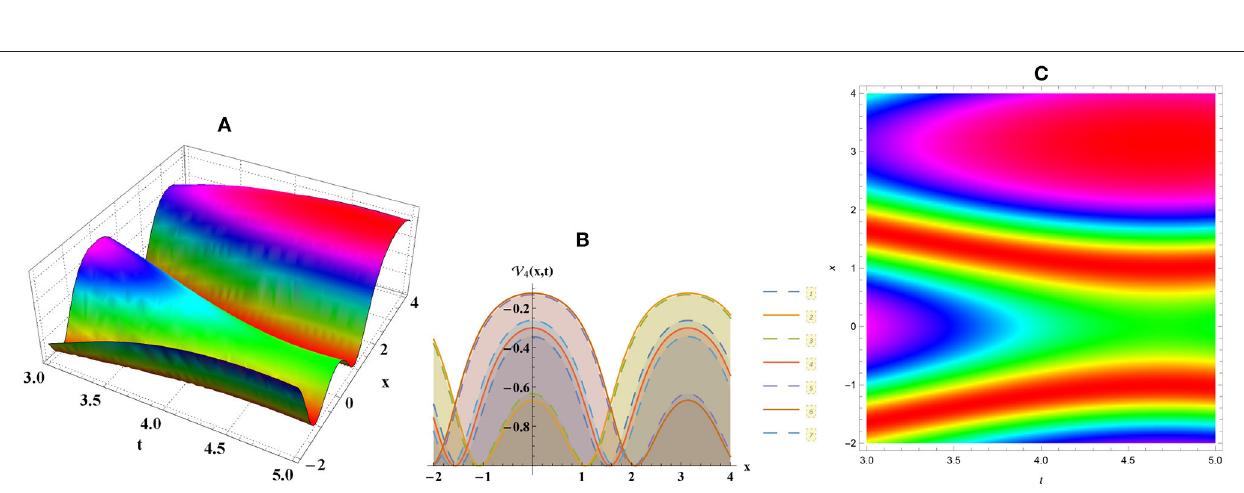
FIGURE 4 | Periodic numerical graph for Equation (8) through (A) three-dimensional, (B) two-dimensional, and (C) density plots.